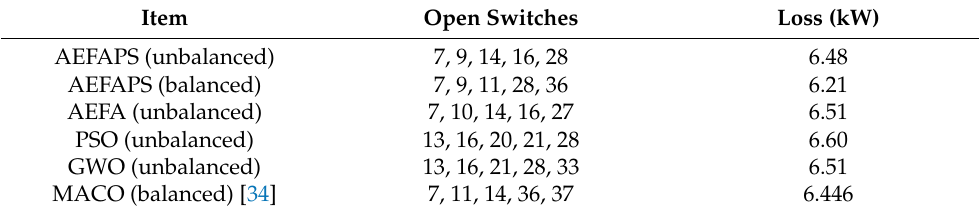
Table 11. Comparative results of the unbalanced 33-bus network incorporating reliability.